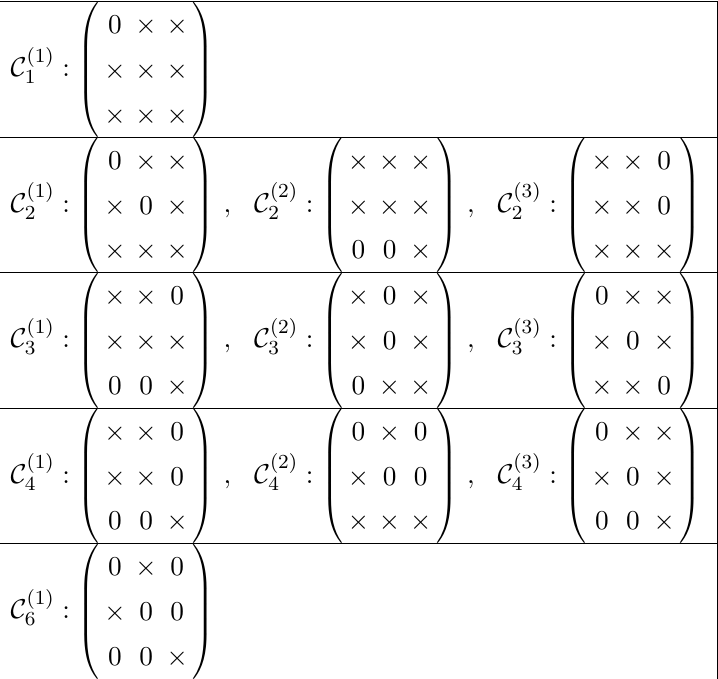
Table 1. Texture-zero classification for the (rank-3) charged-lepton mass matrices which can be realised from T 0 modular symmetry, up to row and column